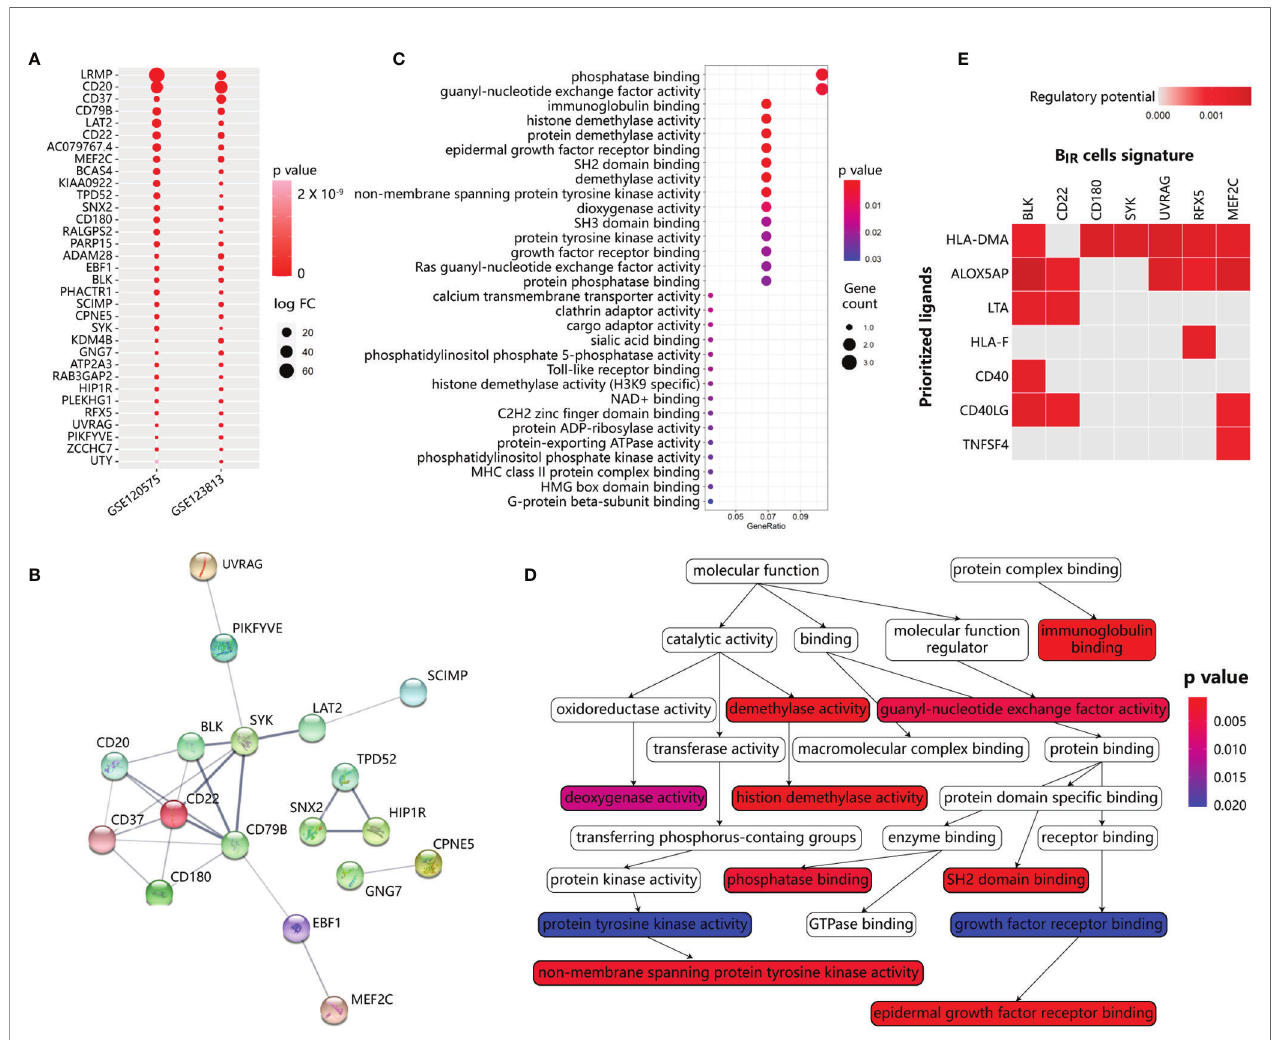
FIGURE 4 | Functional annotation and network analysis of B IR cells signature. (A) Speci fi c gene signature of B IR cells compared with other clusters. 33 genes are speci fi cally expressed in B IR cells in both scRNA-seq data sets. P values are indicated by color. The average fold change in expression of each gene in B IR cells compared with other clusters are indicated by circle size. (B) Protein-protein interaction (PPI) network diagram for 33 genes among B IR cells signature. The colorful network nodes and the lines represent proteins and protein-protein associations, respectively. The line thickness re fl ects the PPI strength between each protein pairs. (C) Signi fi cant gene sets enriched in B IR cells signature. For each gene set, the gene counts enriched in this gene set are indicated by circle size, and p value for the enrichment of this gene set is indicated by color. (D) Relationship of gene sets enriched in B IR cells signature. Each gene set points to its subsets with an arrow, and signi fi cant gene sets are marked with p value-de pendent color. (E) NicheNet analysis of upstream ligand-target pairs inducing genes of B IR cells signature. Regulatory potential scores are calculated for each ligand-target pair, which indicates the ability of ligands to induce the expression of these genes from ICI-response B cells signature. In the heatmaps, the top 7 ligands (out of 324 1igands) and top 7 targets from 33 genes of B IR cells signature are